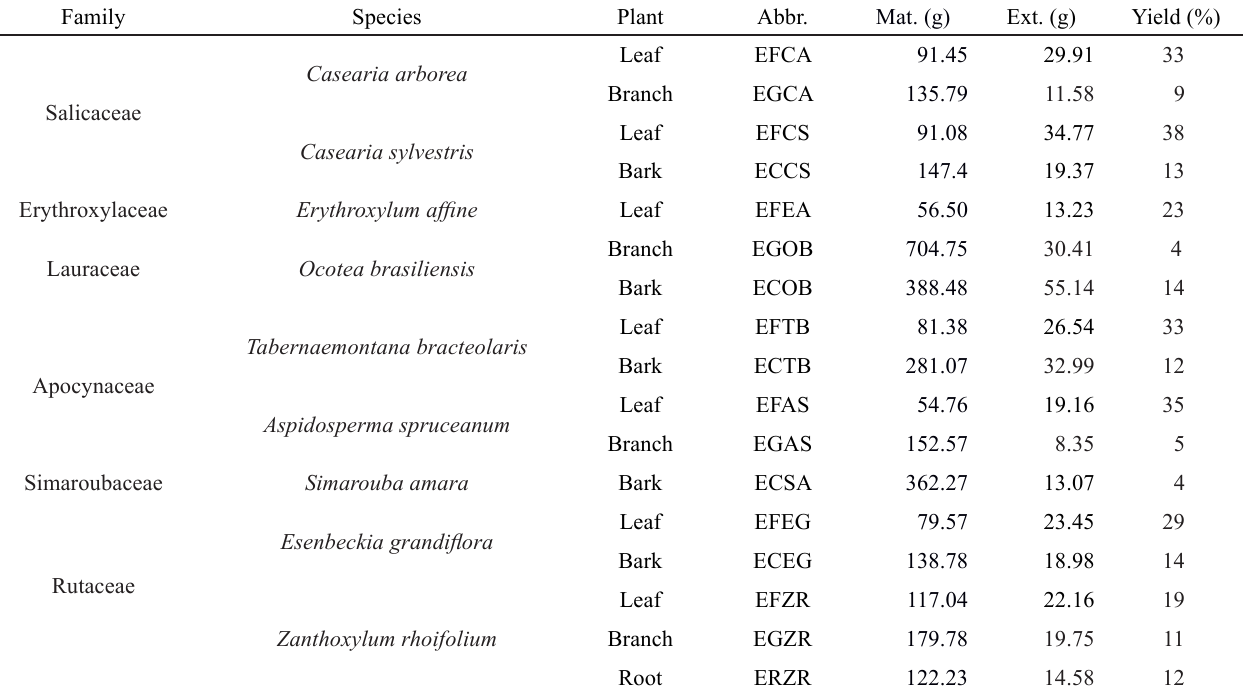
Table 1 . Family, species, plant parts (Plant), abbreviation (Abbr.), mass of dry material (Mat.), mass of extract (Ext.) and yield of plant